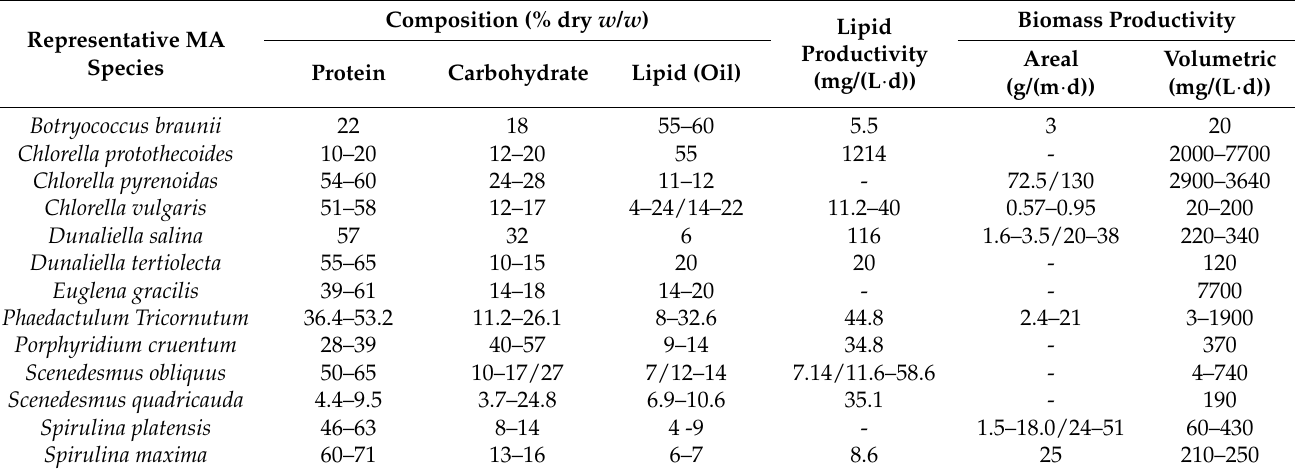
Table 1. The compositions and productivities of the commonly used MA species for wastewater treatment